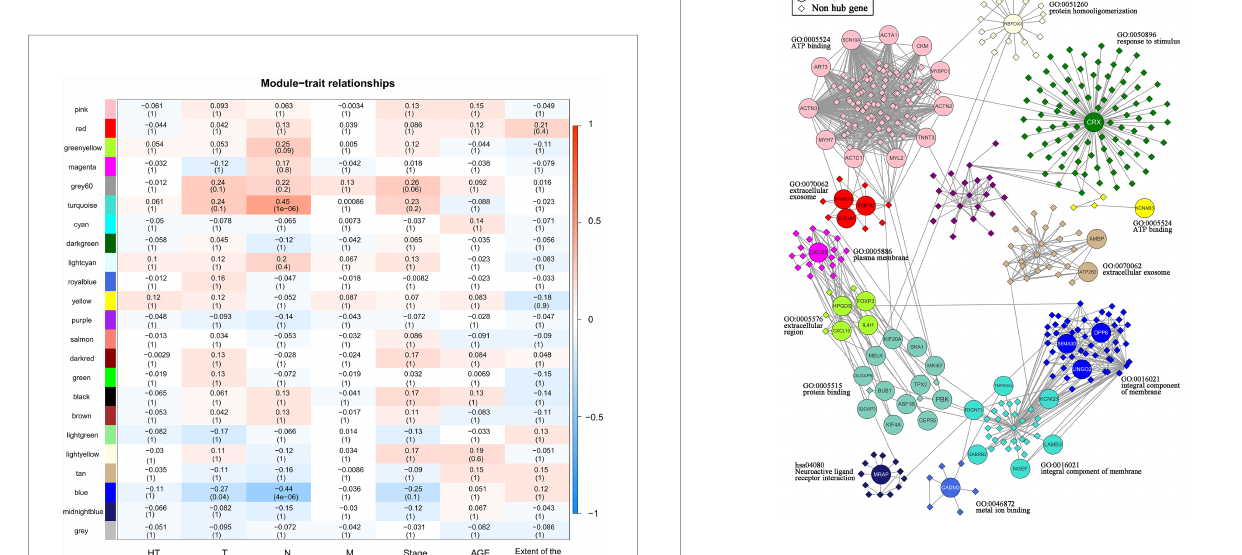
FIGURE 6 | Network of the 47 hub genes and the 13 modules containing these hub genes. 47 hub genes: ACTA1, ACTC1, ACTN2, ACTN3, AMBP, ART3, ASF1B, ATP2B2, B3GNT3, BUB1, CADM2, CEP55, CKM, CRX, CXCL10, CXCR5, DLGAP5, DPP6, FGF10, FOXP3, GABRB2, HPGDS, IL4I1, IQGAP3, KCNAB3, KCNQ3, KIF20A, KIF4A, LAMB3, LINGO2, MELK, MKI67, MRAP, MYBPC1, MYH7, MYL2, NGEF, PBK, RBFOX3, SCN10A, SEMA3D, SKA1, SLC1A7, TMPRSS4, TNNT3, TPX2,